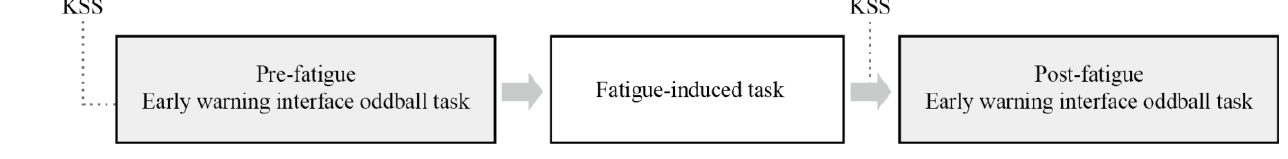
Figure 1. Experimental